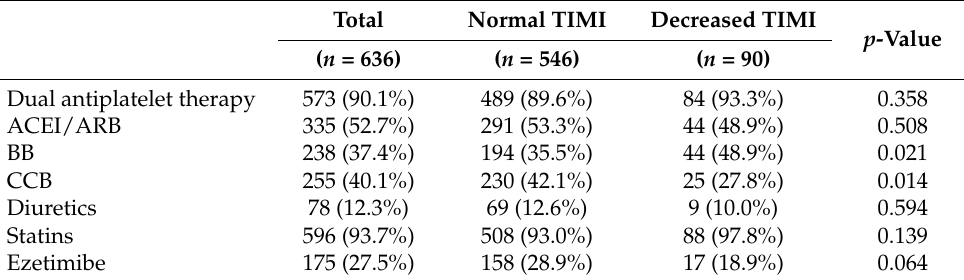
Table 2. Discharge medications of the study